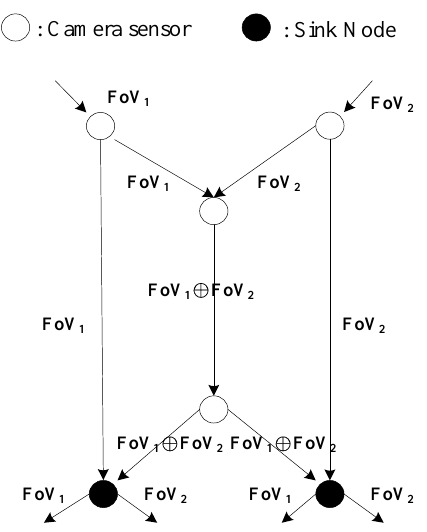
Figure 3. Network coding in WVSN.